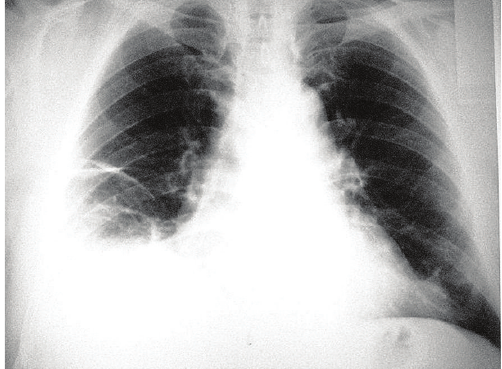
F 3: Northwest radiography showing the normal chest radio- graph aer the